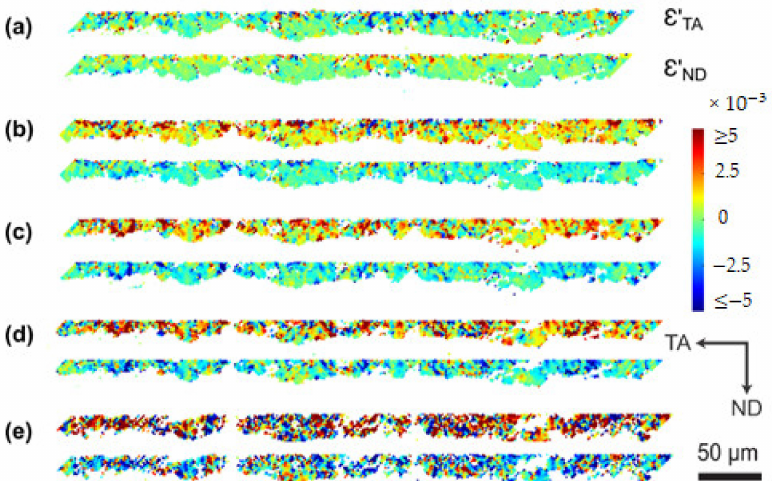
Figure 9. Maps of the deviatoric strains ε (cid:48) TA and ε (cid:48) ND for the top Ti layer. ( a ) Before tensile loading; ( b ) after a strain of 0.23%; ( c ) 0.45%; ( d ) 0.83; ( e ) 1.66%. The scanned region for the initial state is slightly smaller than the other four states.